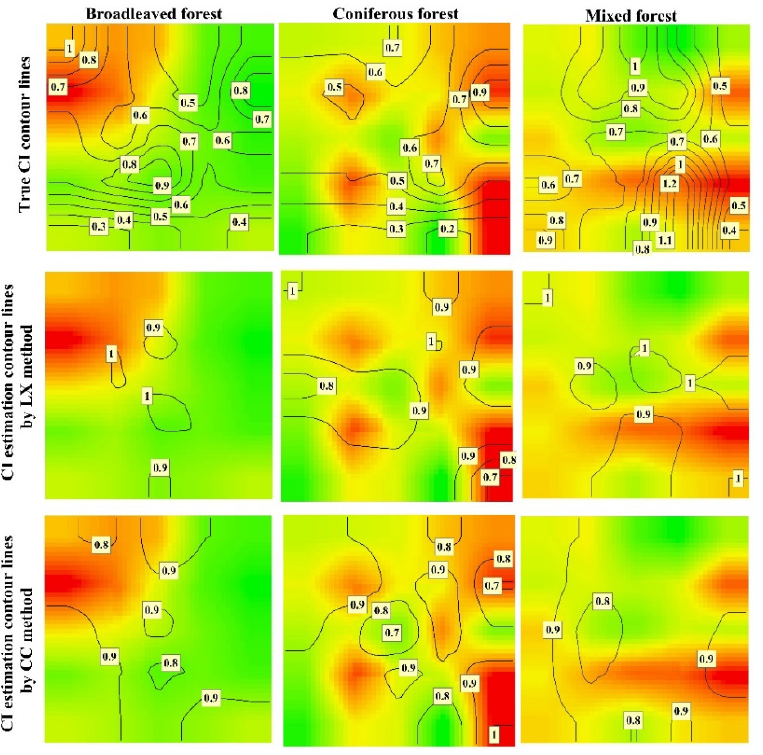
Figure 8. The spatial distribution of CI estimation using different methods in the plot (note: the contour lines show the CI estimation using various methods).